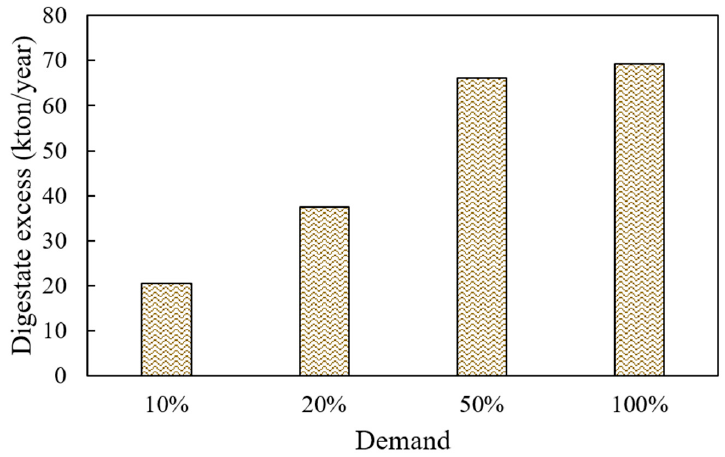
Figure 5. Digestate generated in excess by the biogas supply chain to different energy demand of the studied geographical region.